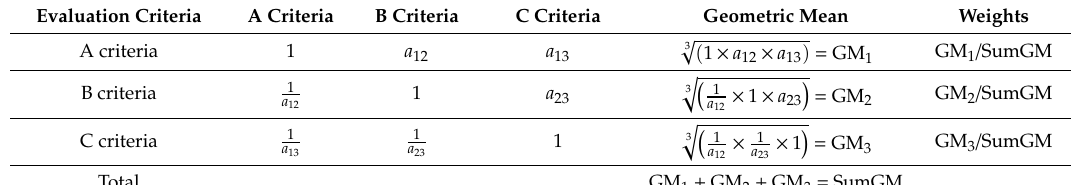
Figure 3. The hierarchical value tree and questionnaire for the AHP analysis. Table 2. An example of a pairwise comparison process for the secondary three criteria [28].